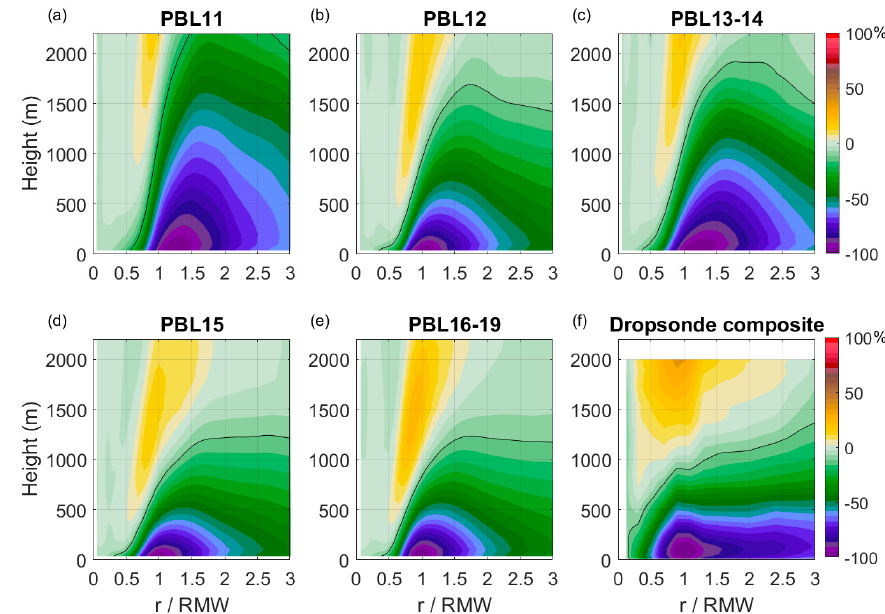
Figure 6. Normalized radius-height plot of the azimuthally averaged radial wind speed normalized by the peak inflow strength ( < u >/|< u > min | ) over t = 84–108 h in the idealized HWRF simulations with ( a ) PBL11, ( b ) PBL12, ( c ) PBL13–14, ( d ) PBL15, and ( e ) PBL16–19 schemes. The dropsonde composite of < u >/|< u > min | is shown in ( f ). The black line denotes the inflow layer depth. RMW is the radius of maximum wind speed. Negative value of u represents inflow.